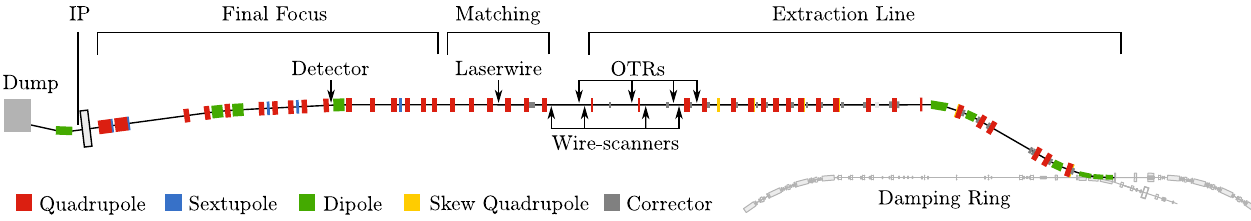
FIG. 1. Schematic of the ATF2 extraction line showing the location of the laserwire system as well as the detector located immediately behind the first dipole magnet after the laserwire interaction point. The wire scanners and OTR monitors are also shown at the end of the extraction line section. All quadrupoles and sextupoles in the matching and final focus sections are on individual three-axis mover